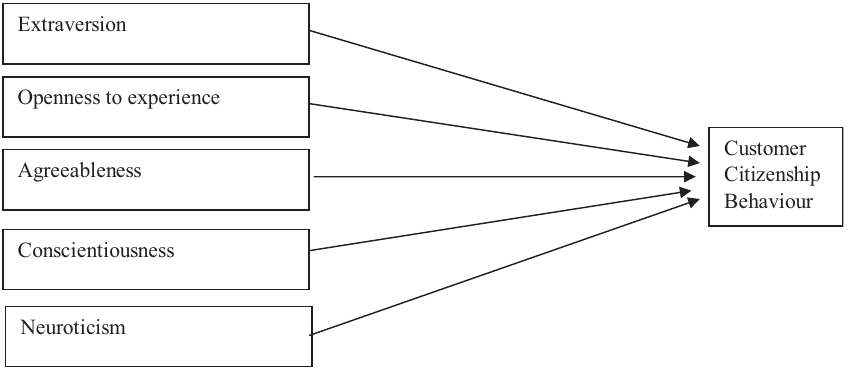
Figure 1. Conceptual